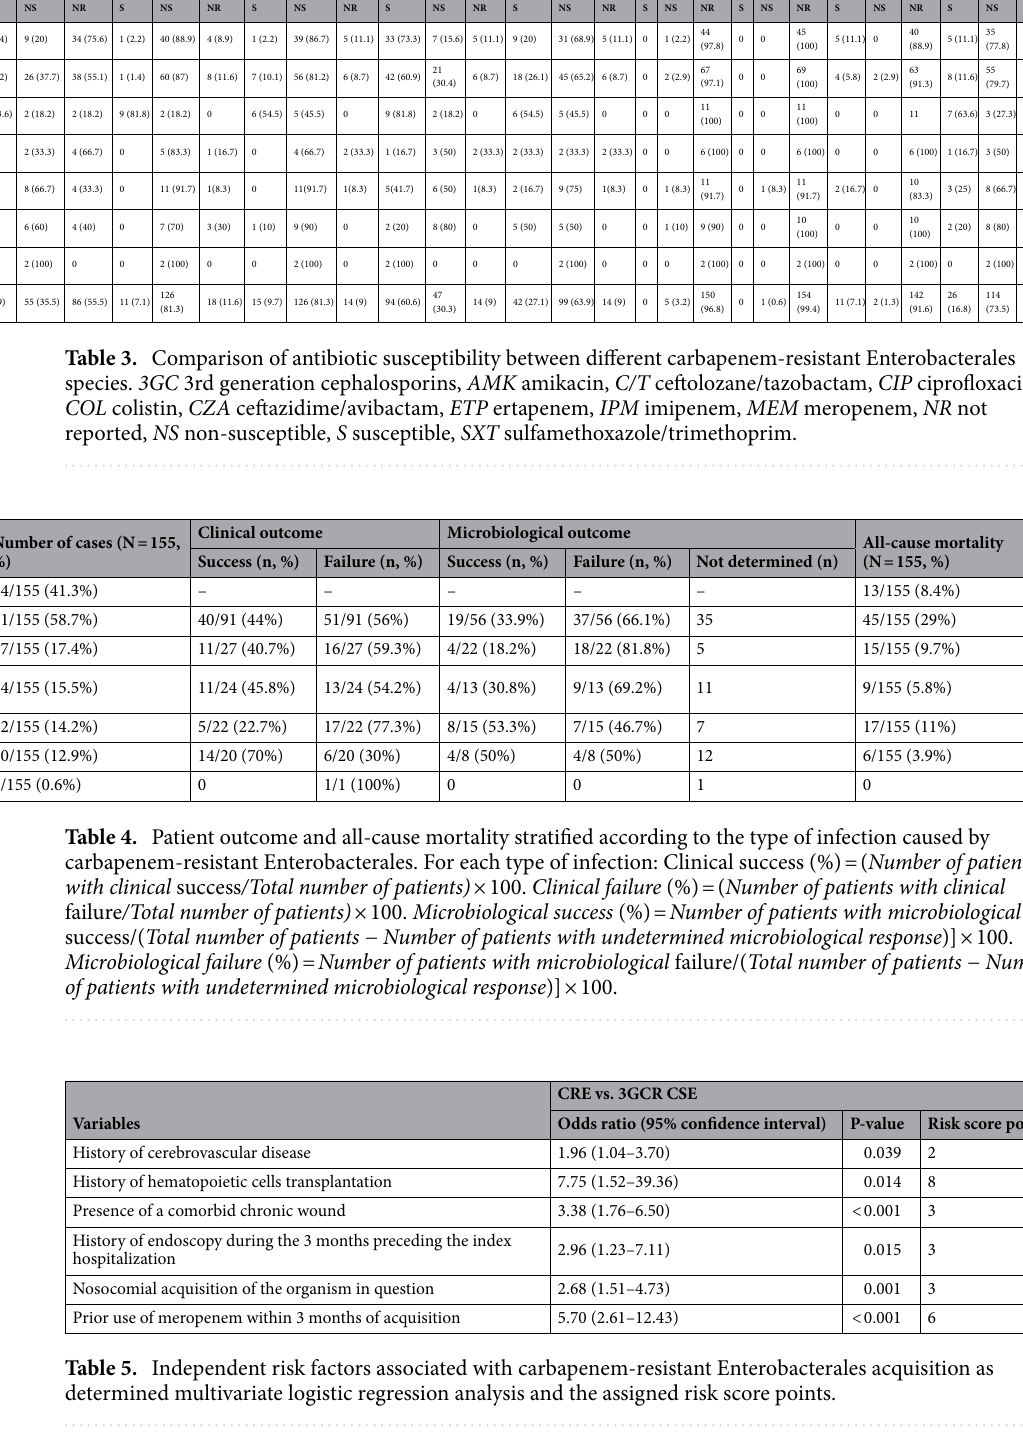
Using a score cutoff 5 to indicate high risk of acquisition provided the best performance with a sensitivity, speci- ficity, PPV, NPV and accuracy of 64.5%, 85.8%, 82%, 70.7% and 75%, respectively. The PLR and NLR associated with a ≥ 5 score cut-off were 4.55 and 0.41, respectively. When a score of 6 and above is used as a cutoff point to distinguish between potential CRE carriers and non-carriers, the sensitivity and specificity ratings were 56.1% and 90.3%, respectively. The PPV, NPV and accuracy were 85.3%, 67.3% and 73%, respectively. The PLR and NLR associated with a ≥ 5 score cut-off were 5.80 and 0.49, respectively (Table 6).